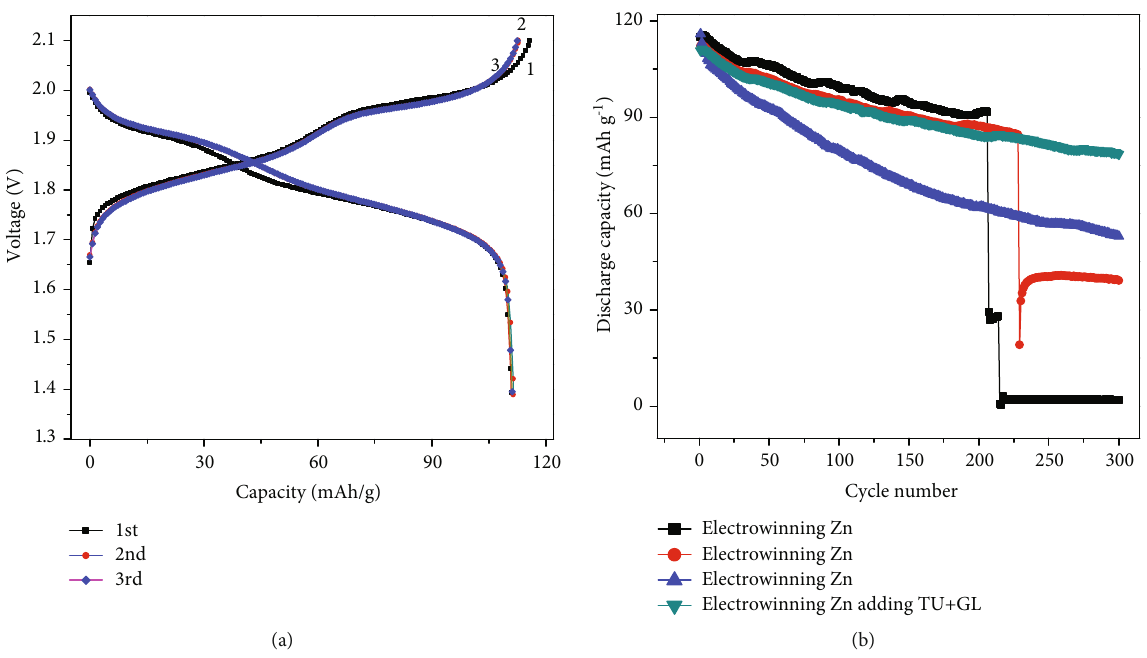
Figure 5: The cycling performance of LiMn